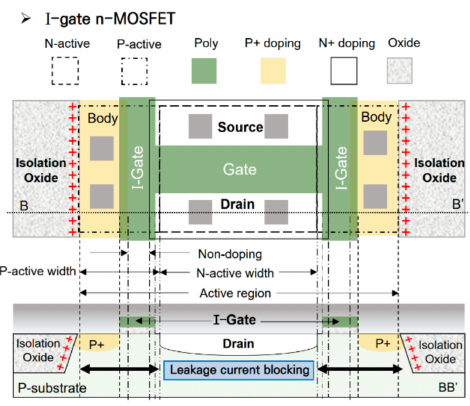
Figure 6. Structure of the CMOS bulk process-based I-gate type